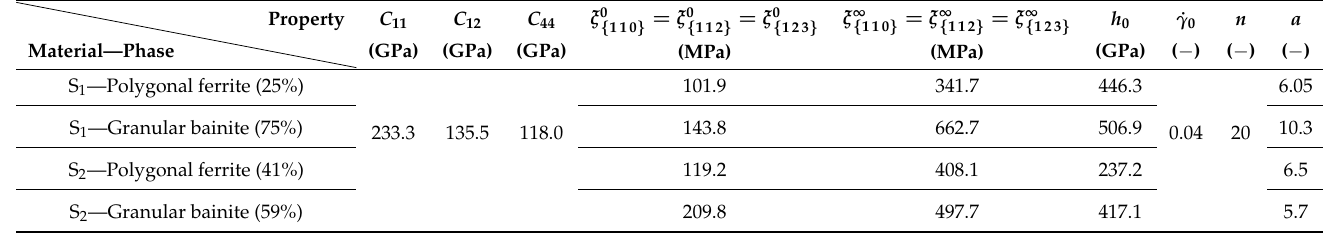
Table 3. Determined crystal plasticity